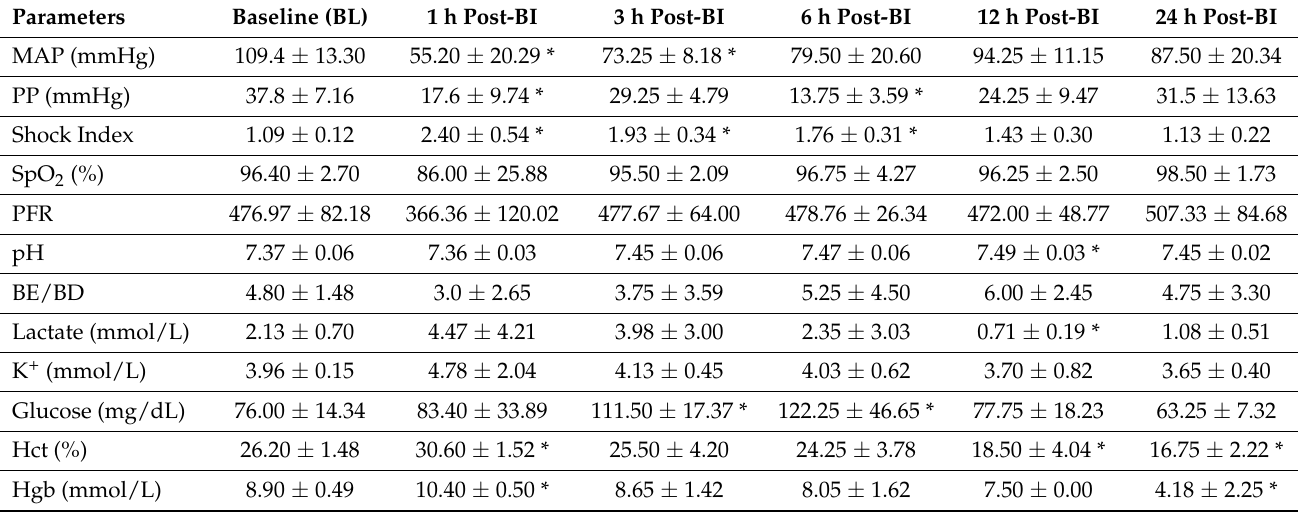
Table 2. Hemodynamic and blood chemistry parameters in a porcine BI+HS model.